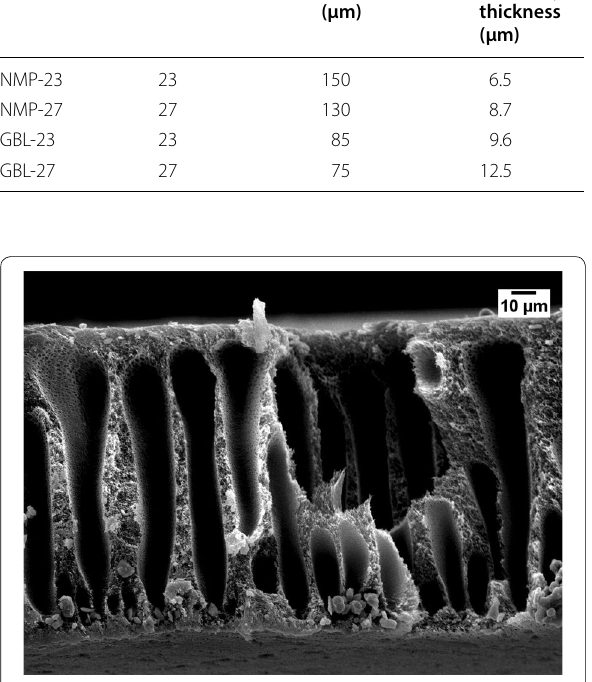
Fig. 5 Cross‑section image of NMP membrane made by 23 wt% PEI